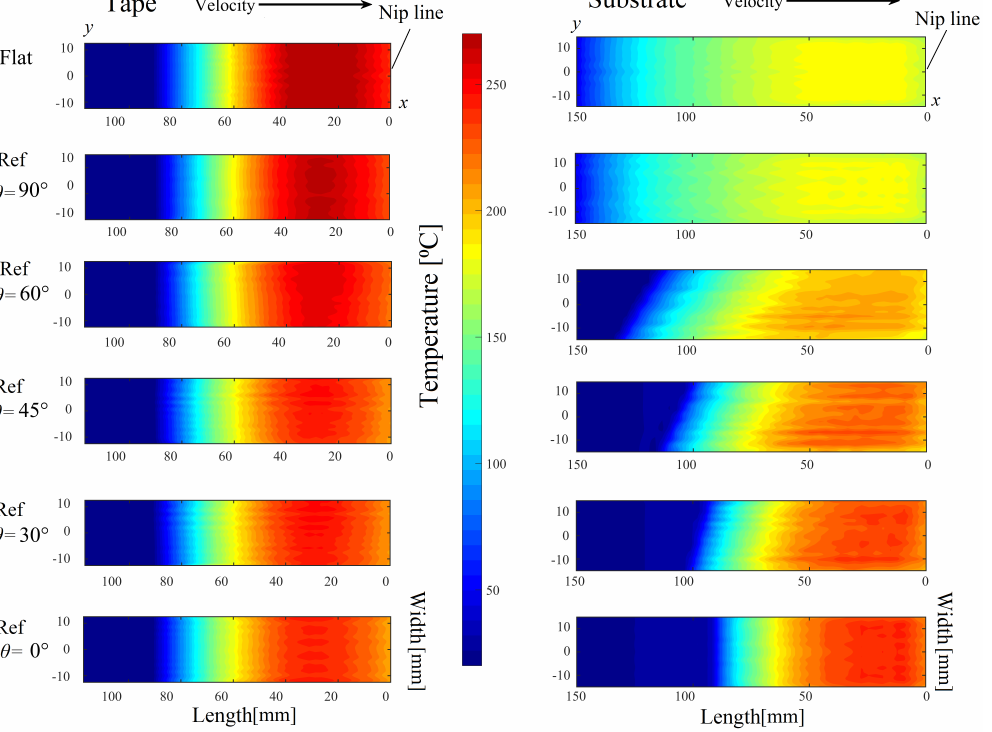
Figure 15. Predicted temperature distribution on the tape and the substrate for the cases Flat and Ref ( W T = 25 mm and W S = 30 mm) using different θ . (For interpretation of the references to color in this figure legend, the reader is referred to the web version of this